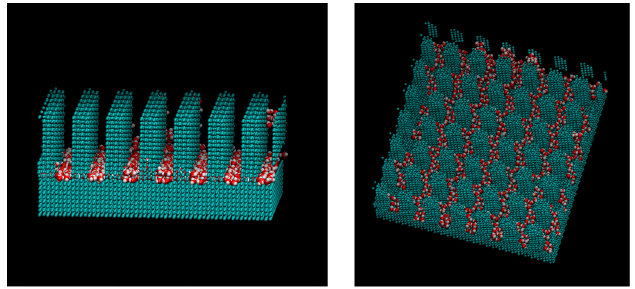
Figure 9. Snapshot of water molecules during the condensation on the ε = 19.74. kJ/mol surface from